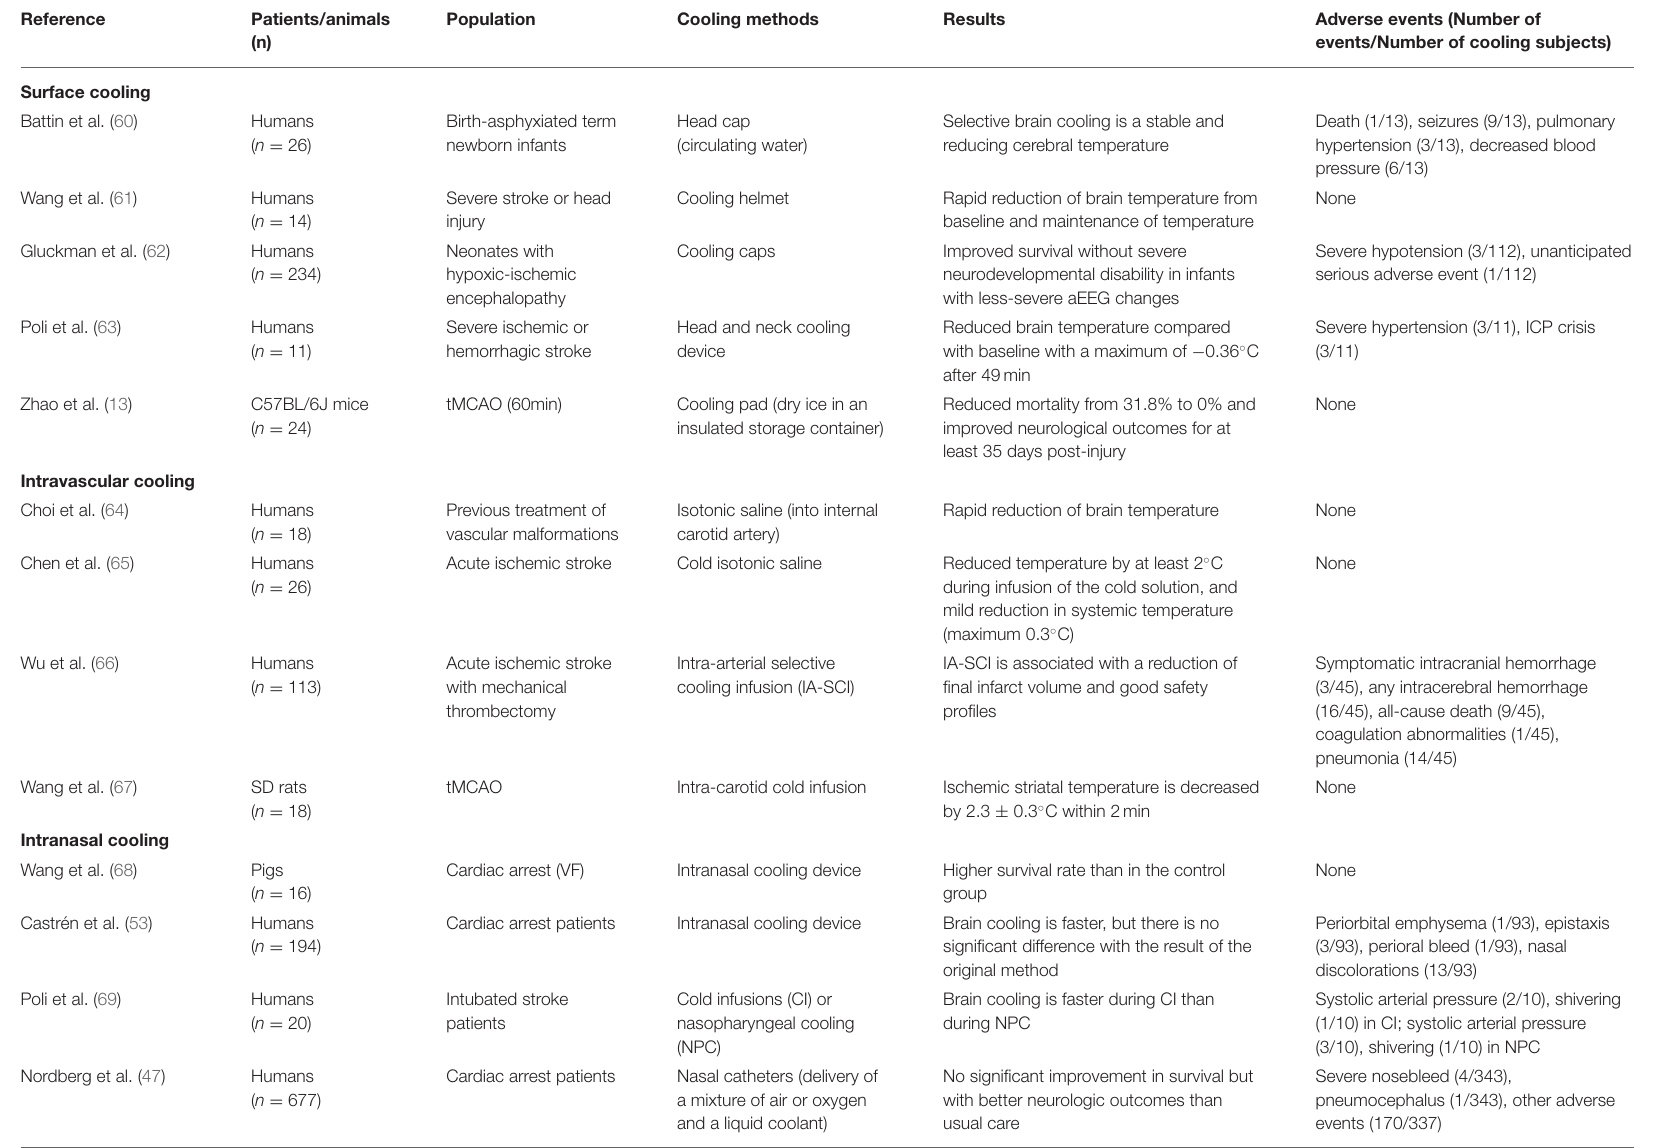
TABLE 1 | Animal and clinical studies on different methods of selective brain